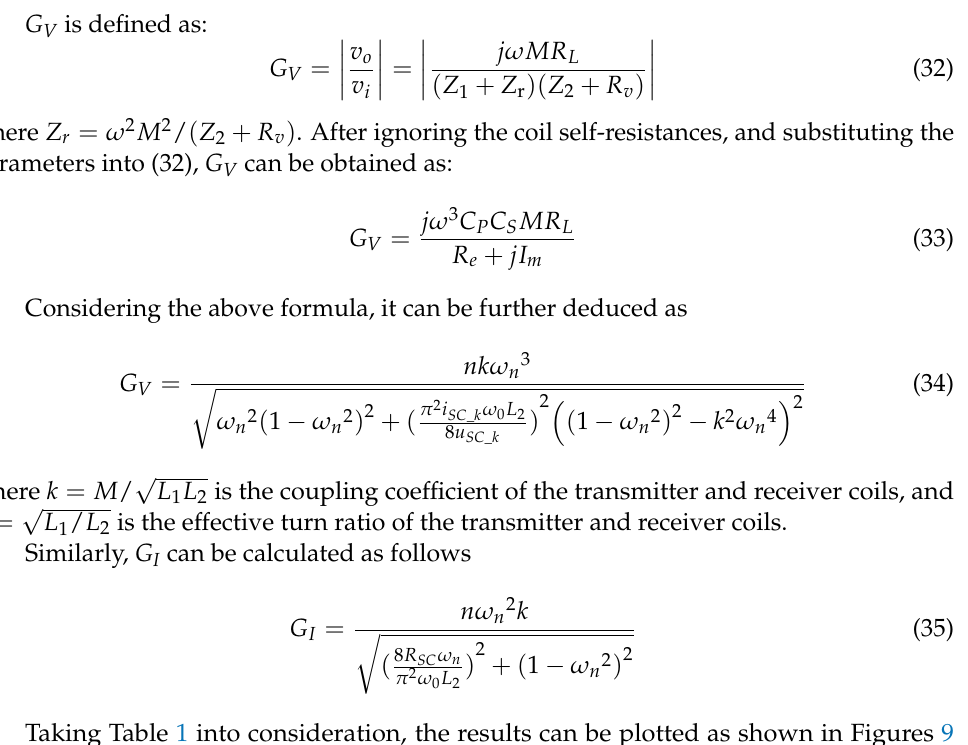
Figure 10. Current gain G I vs. R SC and ω n .